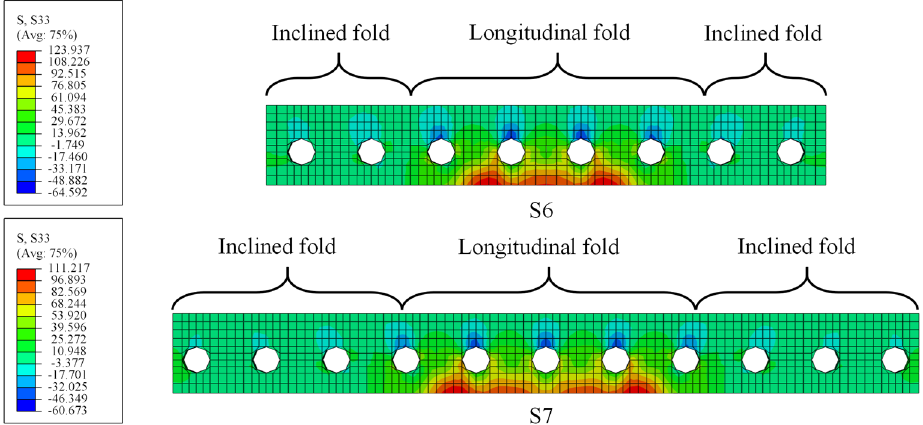
Figure 19. Stress distribution of PBL shear connectors for models with different web corrugations.